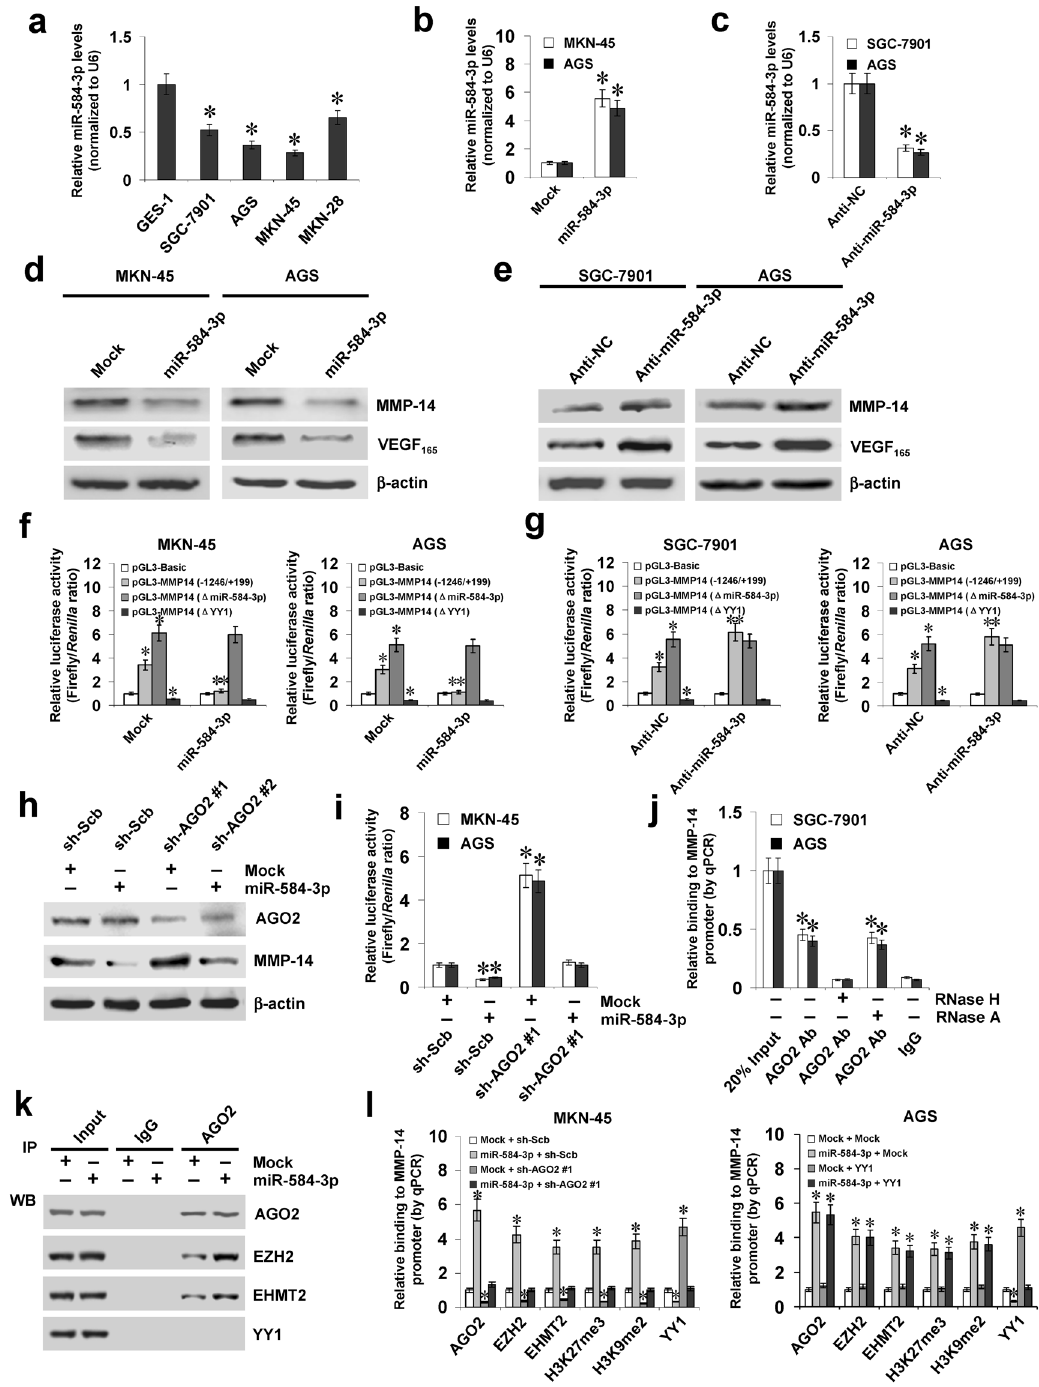
Figure 3. miR-584-3p interacts with AGO2 to repress the YY1-facilitated MMP-14 transcription. (a ) Real- time quantitative RT-PCR assay showing the expression of miR-584-3p in normal gastric epithelial GES-1 cells and gastric cancer cell lines SGC-7901, AGS, MKN-45, and MKN-28 (mean ± SD, n = 4). ( b and c ) Real-time quantitative RT-PCR assays indicating the expression of miR-584-3p in gastric cancer cells transfected with empty vector (mock), miR-584-3p precursor, negative control inhibitor (anti-NC, 100 nmol/L), or anti-miR- 584-3p inhibitor (100 nmol/L) (mean ± SD, n = 4). ( d and e ) Western blot assay showing the expression of MMP-14 and VEGF 165 in gastric cancer cells transfected with mock, miR-584-3p precursor, anti-NC (100 nmol/L), or anti-miR-584-3p inhibitor (100 nmol/L). ( f and g ) Dual-luciferase assay indicating the MMP- 14 promoter activity (normalized to pGL3-Basic) in gastric cancer cells transfected with mock, miR-584-3p precursor, anti-NC (100 nmol/L), or anti-miR-584-3p inhibitor (100 nmol/L; mean ± SD, n = 4). ( h and i ) Western blot and dual-luciferase assays showing the expression of AGO2 and MMP-14 and activity of MMP- 14 promoter reporter [pGL3-MMP14 ( − 1246/ + 199)] in gastric cancer cells stably transfected with mock